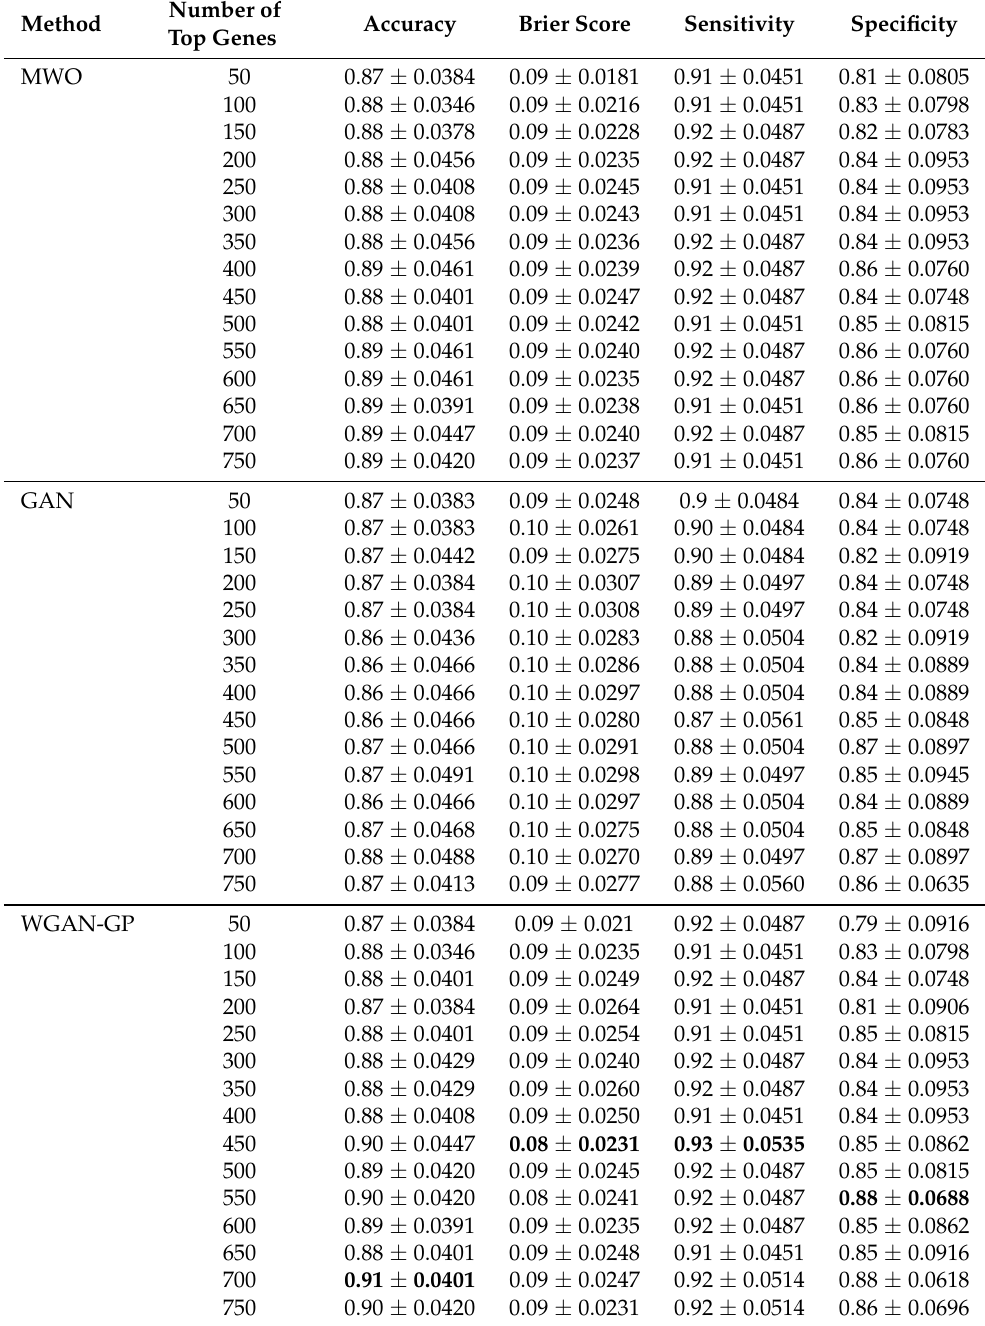
Table 2. Classification performance measures for microarray data (test subsets) after training with augmented training data either augmented with mixed weighted observations (‘MWO’), a standard generative adversarial network (‘GAN’) or the advanced Wasserstein GAN with gradient penalty (‘WGAN-GP’) with the number of synthetic samples being two times the number of original samples in each class, respectively. The table shows the 95% confidence intervals (mean ± 1.96 standard errors) for accuracy, Brier score, sensitivity and specificity, respectively. Values in bold are the best scores for the respective performance